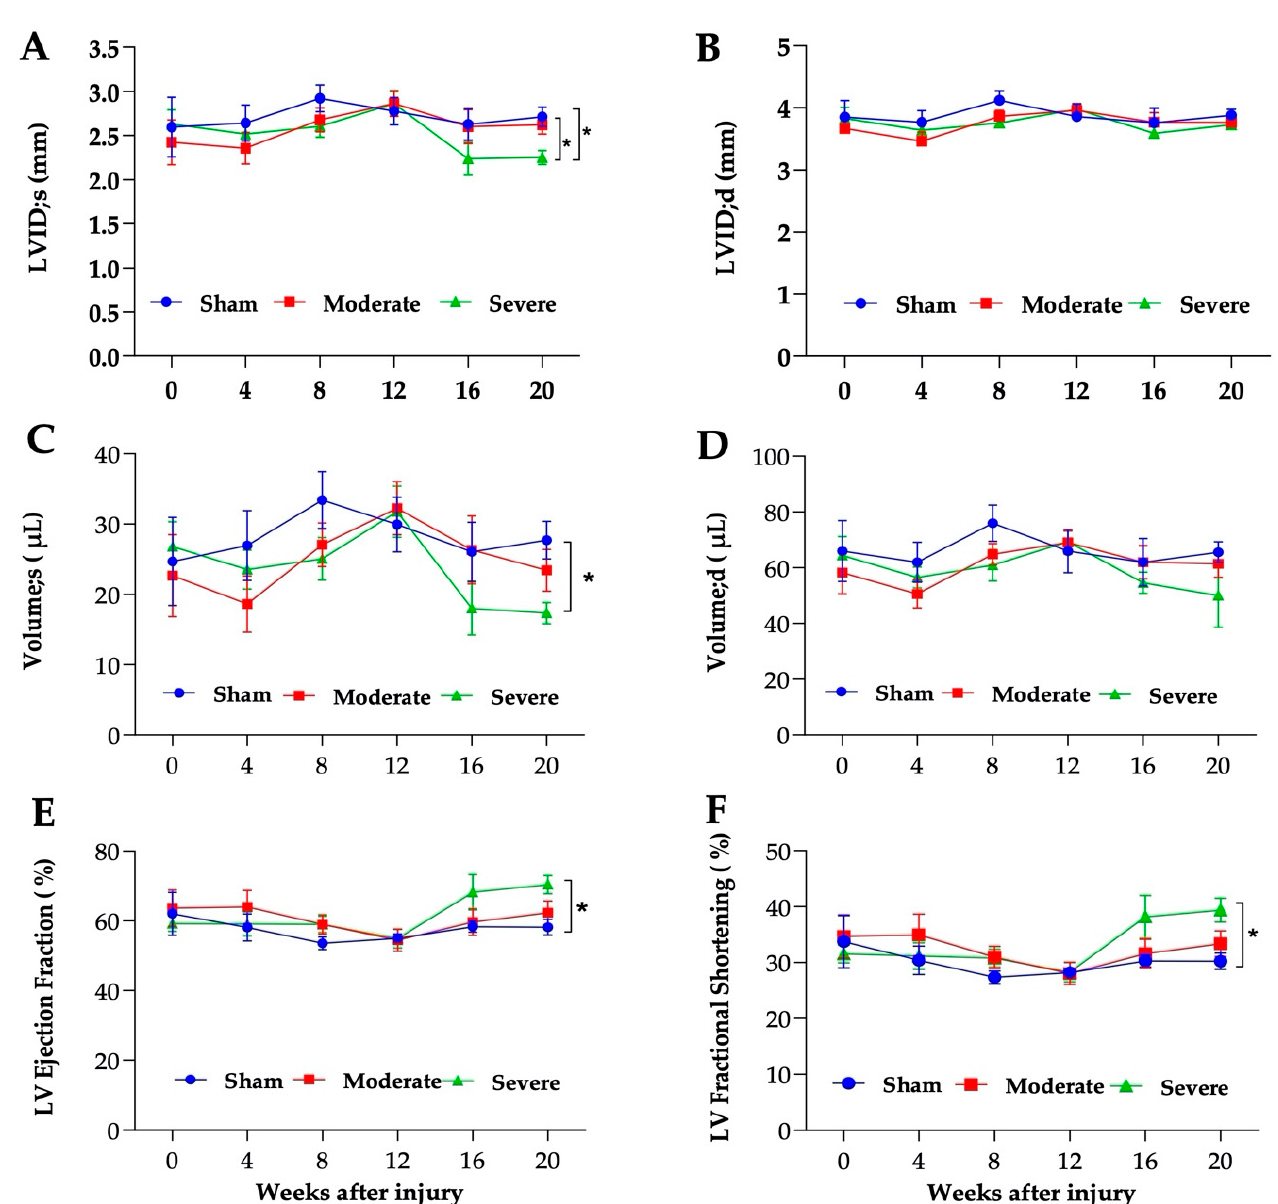
Figure 5. Injury-severity dependent development of cardiac dysfunction. Echocardiography as- sessment. ( A ) Left ventricular internal diameter during systole (LVID;s) and ( B ) during diastole (LVID;d). ( C ) LV volume during systole and ( D ) LV volume during diastole. ( E ) Ejection fraction (EF) and ( F ) fractional shortening (FS). n = 6 (sham), 8 (moderate), and 5–9 (severe). Data analyzed by two-way ANOVA. Tukey’s multiple comparisons test was used to determine the differences between the groups. Data presented as mean ± SEM, * p ≤ 0.03, ** p ≤ 0.002, *** p ≤ 0.001.